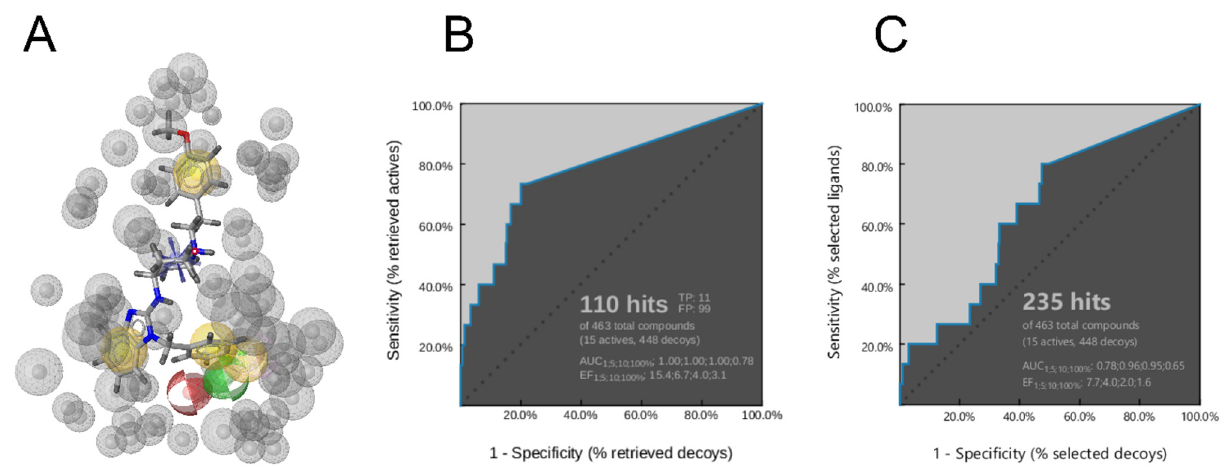
Figure 13. ( A ) Alignment of astemizole with the final three-dimensional merged pharmacophore model used for the virtual screening. Gray spheres show exclusion volumes. ( B , C ) Resulting ROC curves (blue) from the virtual screening of 463 compounds (15 K V 10.1 inhibitors; 448 decoys [hERG inactive compounds based on ChEMBL for IC 50 > 100 μ M]) with the final merged pharmacophore model, with exclusion spheres ( B ) and without exclusion spheres ( C ). TP, true positives; FP, false positives; AUC, area under the curve; EF, enrichment